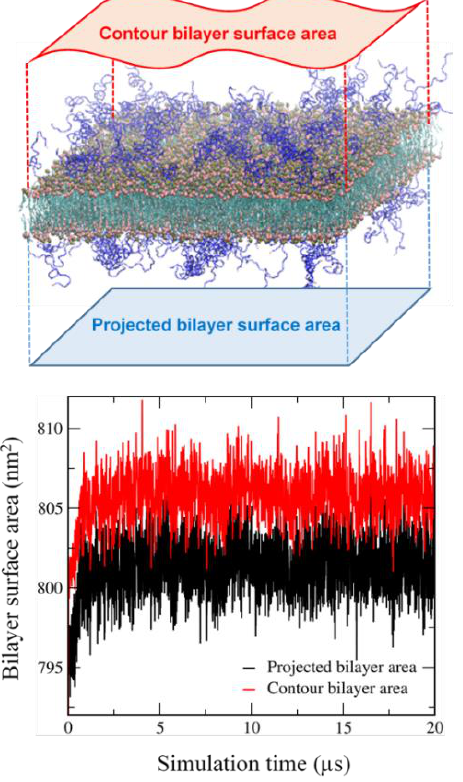
Figure 9. Projected and contour bilayer-surface areas of DOXIL as a function of simulation time.